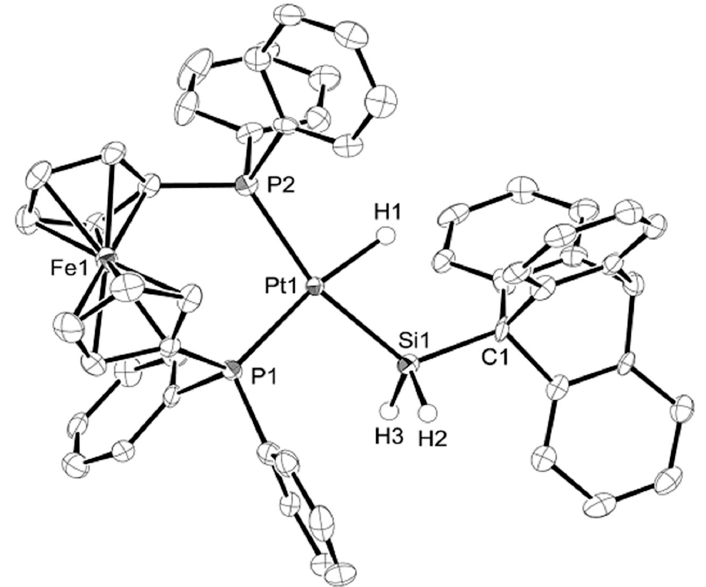
Figure 2. ORTEP of [PtH(SiH 2 Trip)(dppf)] 3 50% thermal ellipsoids, a solvation CH 2 Cl 2 molecule,